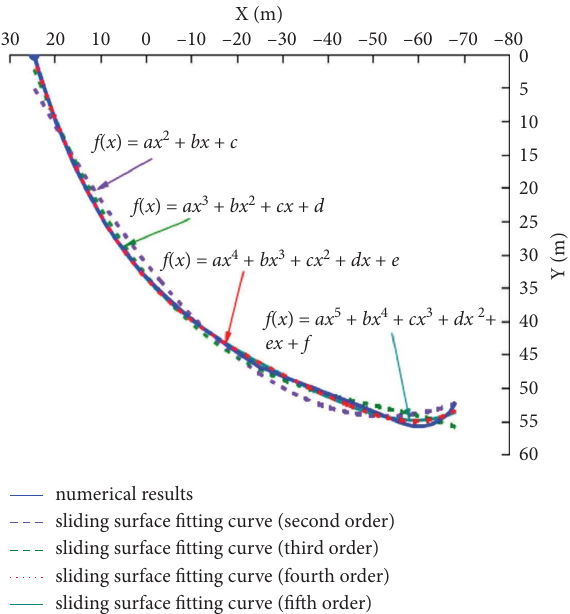
Figure 12: Fitting curve of sliding surface of frst grade